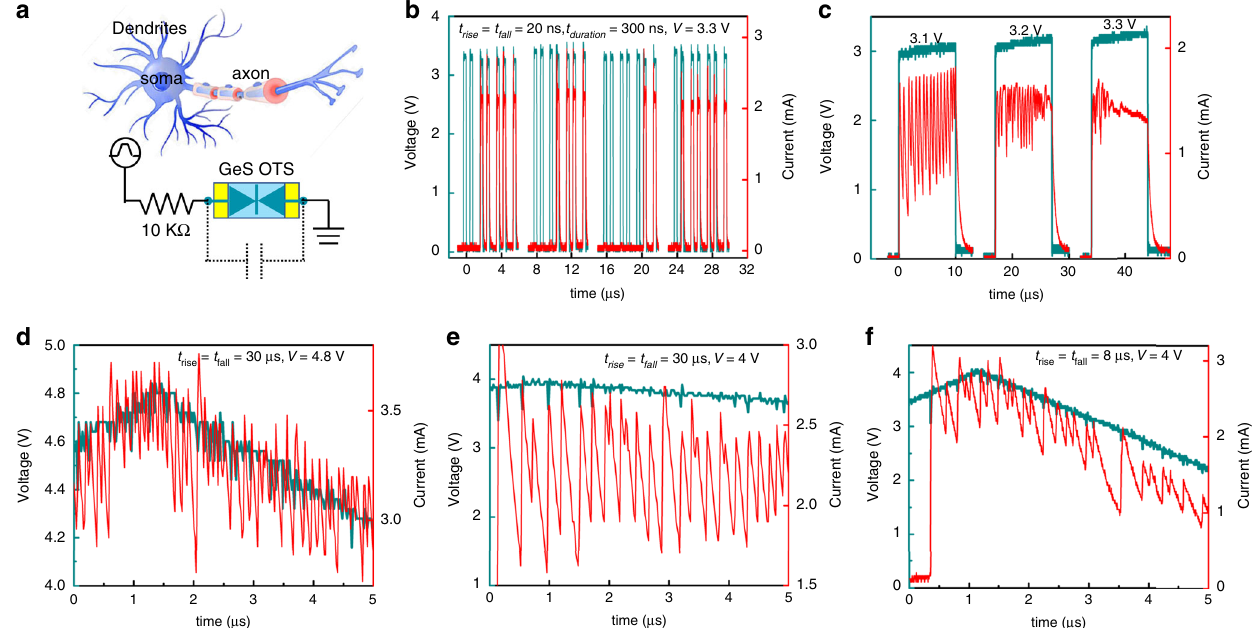
Fig. 3 GeS OTS-based arti fi cial neuron. a Schematic of biological neuron and the arti fi cial spiking neuron. A resistor (10 k Ω ) is in series with the GeS device and the current response across the device is served as the response spiking signal. Reprinted with permission 35 . Copyright (2012) American Chemical Society. b Stochastic behavior of the stimulated neuron applied multiple near-threshold voltage pulses with amplitude (V) of 3.3 V, rising/falling time ( t rise / t fall ) of 20 ns, and the duration time ( t duration ), of 300 ns. c The response under square pulses with different near-threshold voltages. d – f Frequency response of the arti fi cial neuron to which are applied different triangular stimuli pulses, 4.8 V amplitude/30 μ s rising/falling time, 4 V amplitude/30 μ s rising/falling time and 4 V amplitude/8 μ s rising/falling time,